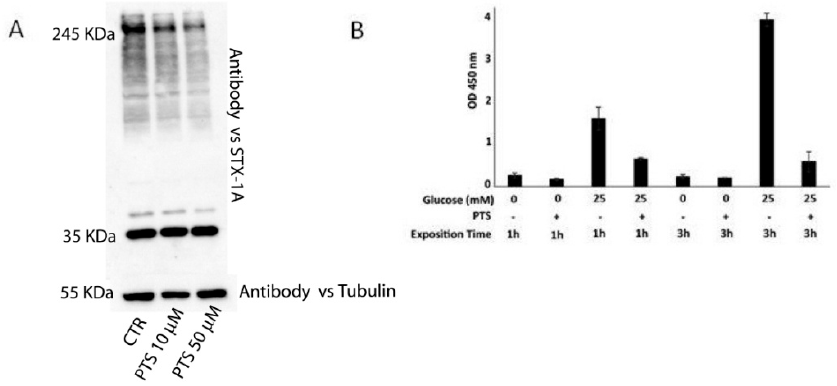
Figure 4. Panel A : Immunoblotting analysis of INS-1 832 / 13 cell lysates, obtained after PTS 6 h pre-incubation on living cells. Panel B : Insulin secretion measured by ELISA assays on INS-1 832 / 13 cells stimulated by glucose in presence or in absence of PTS, mean ± SD of three replicates is shown.